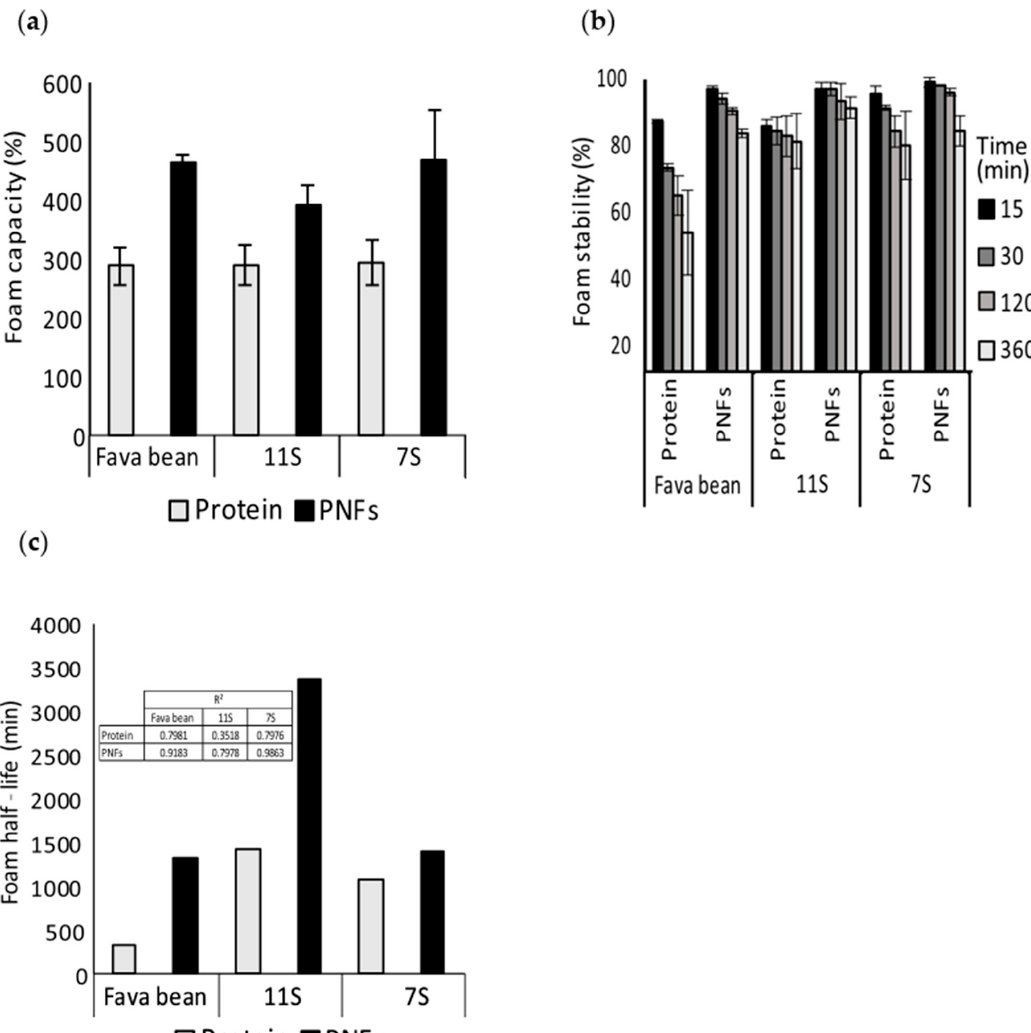
Figure 5. ( a ) Foaming capacity, ( b ) foam stability, and ( c ) foam half-life of non-fibrillated (protein) and fibrillated (protein nanofibrils, PNFs) protein from fava bean and its globular fractions 11S and 7S. The foams were generated at pH 7 and had a concentration of 10 mg/mL. The error bars in figure ( a , b ) refer to the standard deviation, and the insert in ( c ) shows the model fit (R 2 ). To investigate whether these improved foaming properties persisted at very low concentrations for fibrillated protein, foams produced from non-fibrillated (protein) and fibrillated (PNFs) fava bean, 11S, and 7S proteins were diluted to a final concentration of 1 mg/mL at pH 7 (Figure 6a,b). The foaming capacity was found to be almost identical